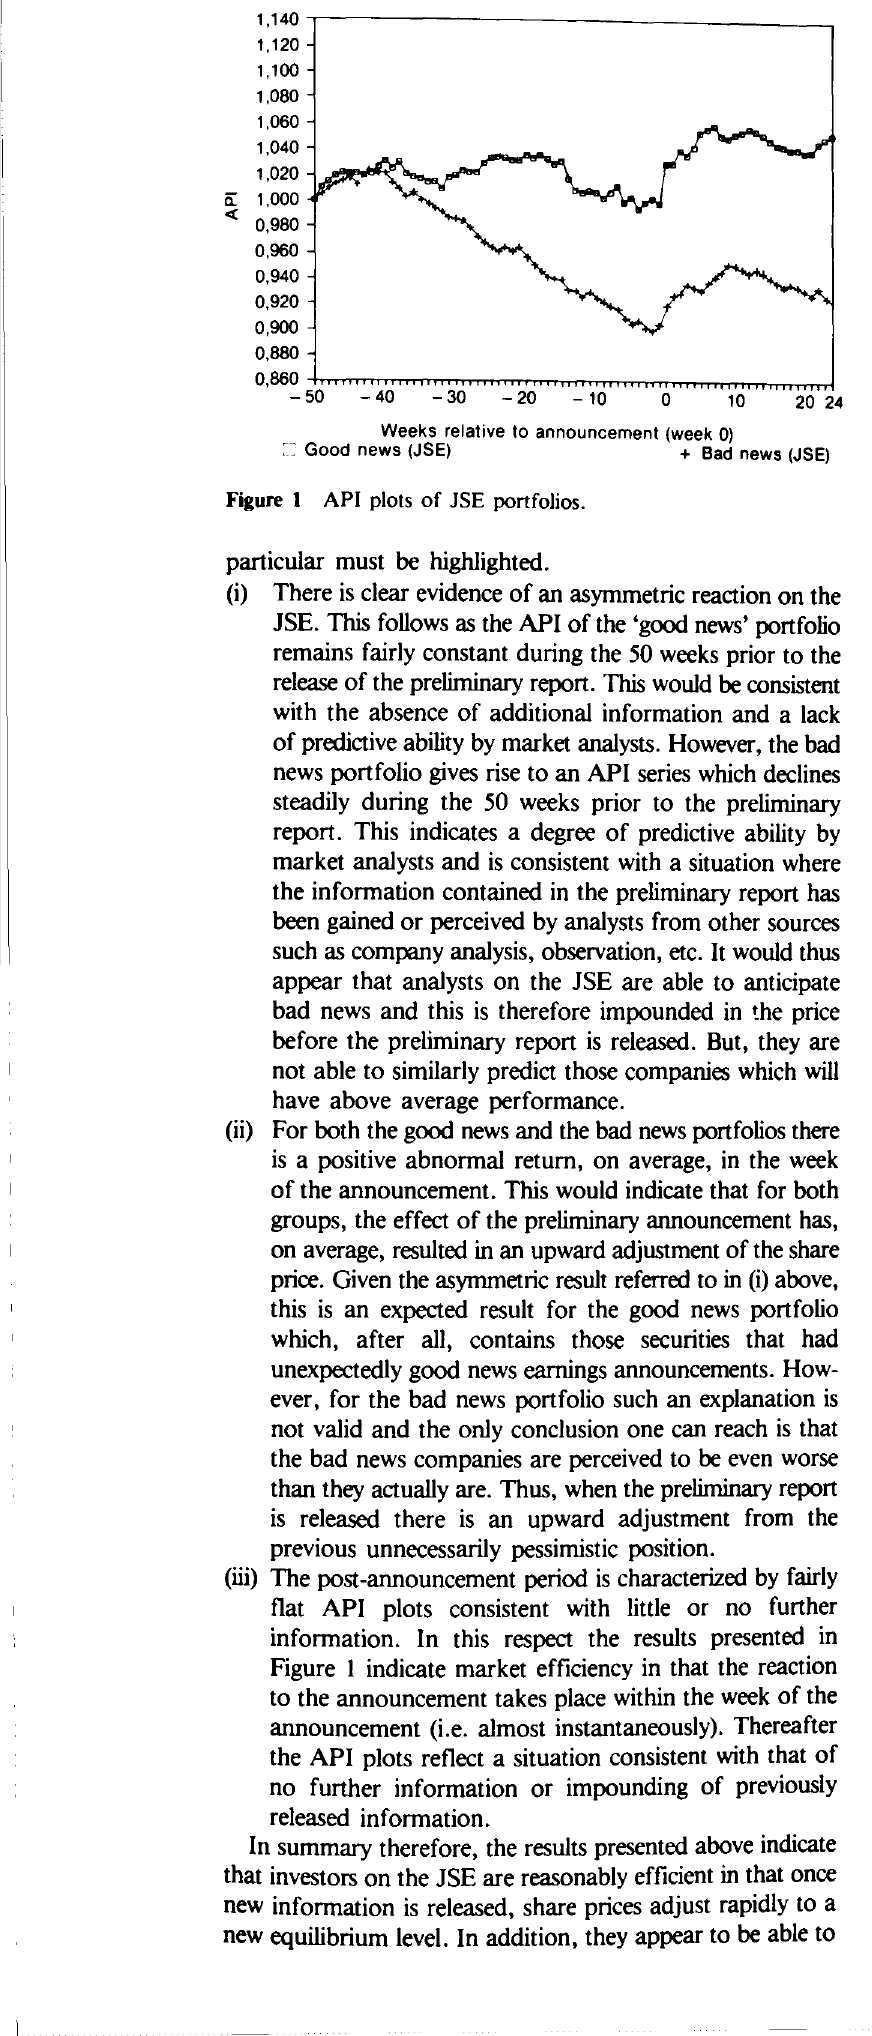
Figure I API plots of JSE portfolios.